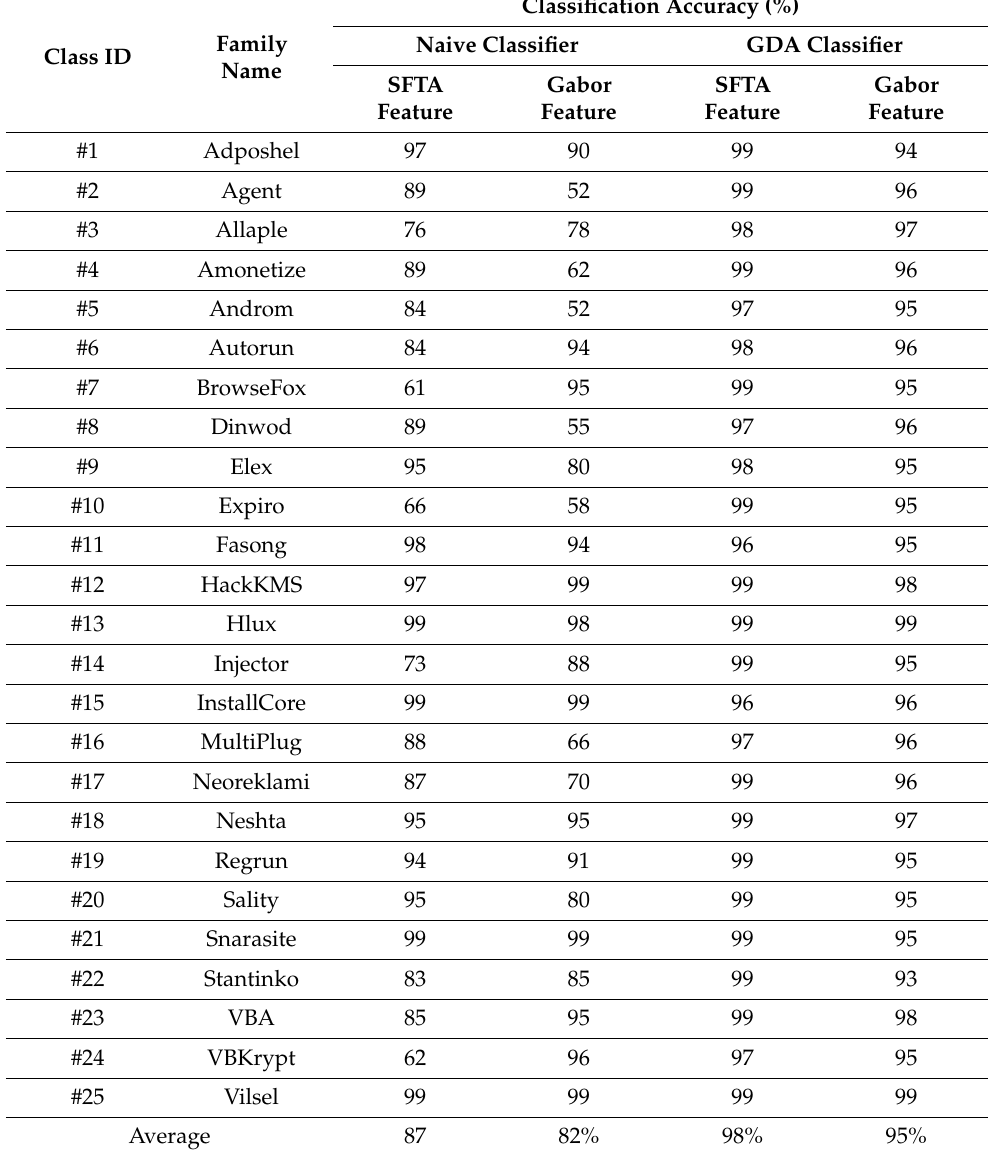
Table 4. Classification Accuracy rate of two classifiers on two features across MaleVis